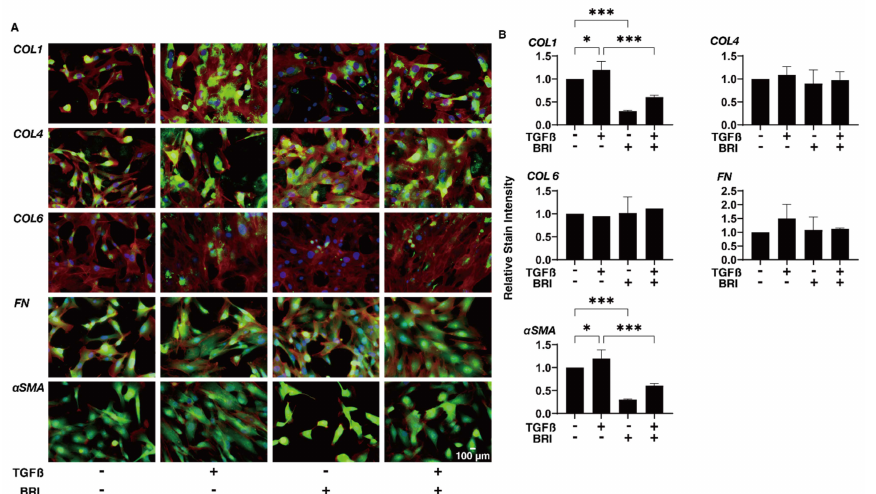
Figure 5. Effects of brimonidine (BRI) on the immunolabeling of ECM molecules in TGF- β 2-treated 2D HTM cells.The 2D-cultured HTM on day 6 were untreated (NT) or treated with 5 ng/mL TGF- β 2 (TGF β ) in the presence or absence of 10 µ M brimonidine (BRI) and were subjected to immunofluo- rescent labeling of ECMs ( COL1 , 4 , or 6 , FN , or a-SMA ). Experiments were conducted in duplicate ( n = 5). Representative merged images with DAPI (blue), phalloidin (red), and anti-ECM images (green) are demonstrated (panel A, scale bar; 100 µ m). “+” is reagents addition. “ − ” is reagents non-addition.The staining intensity ratios relative to NT are plotted in panel B. Regarding the data, the mean ± standard error of the mean (SEM) are shown. * p < 0.05, *** p < 0.005; ANOVA followed by a Tukey’s multiple comparison test.